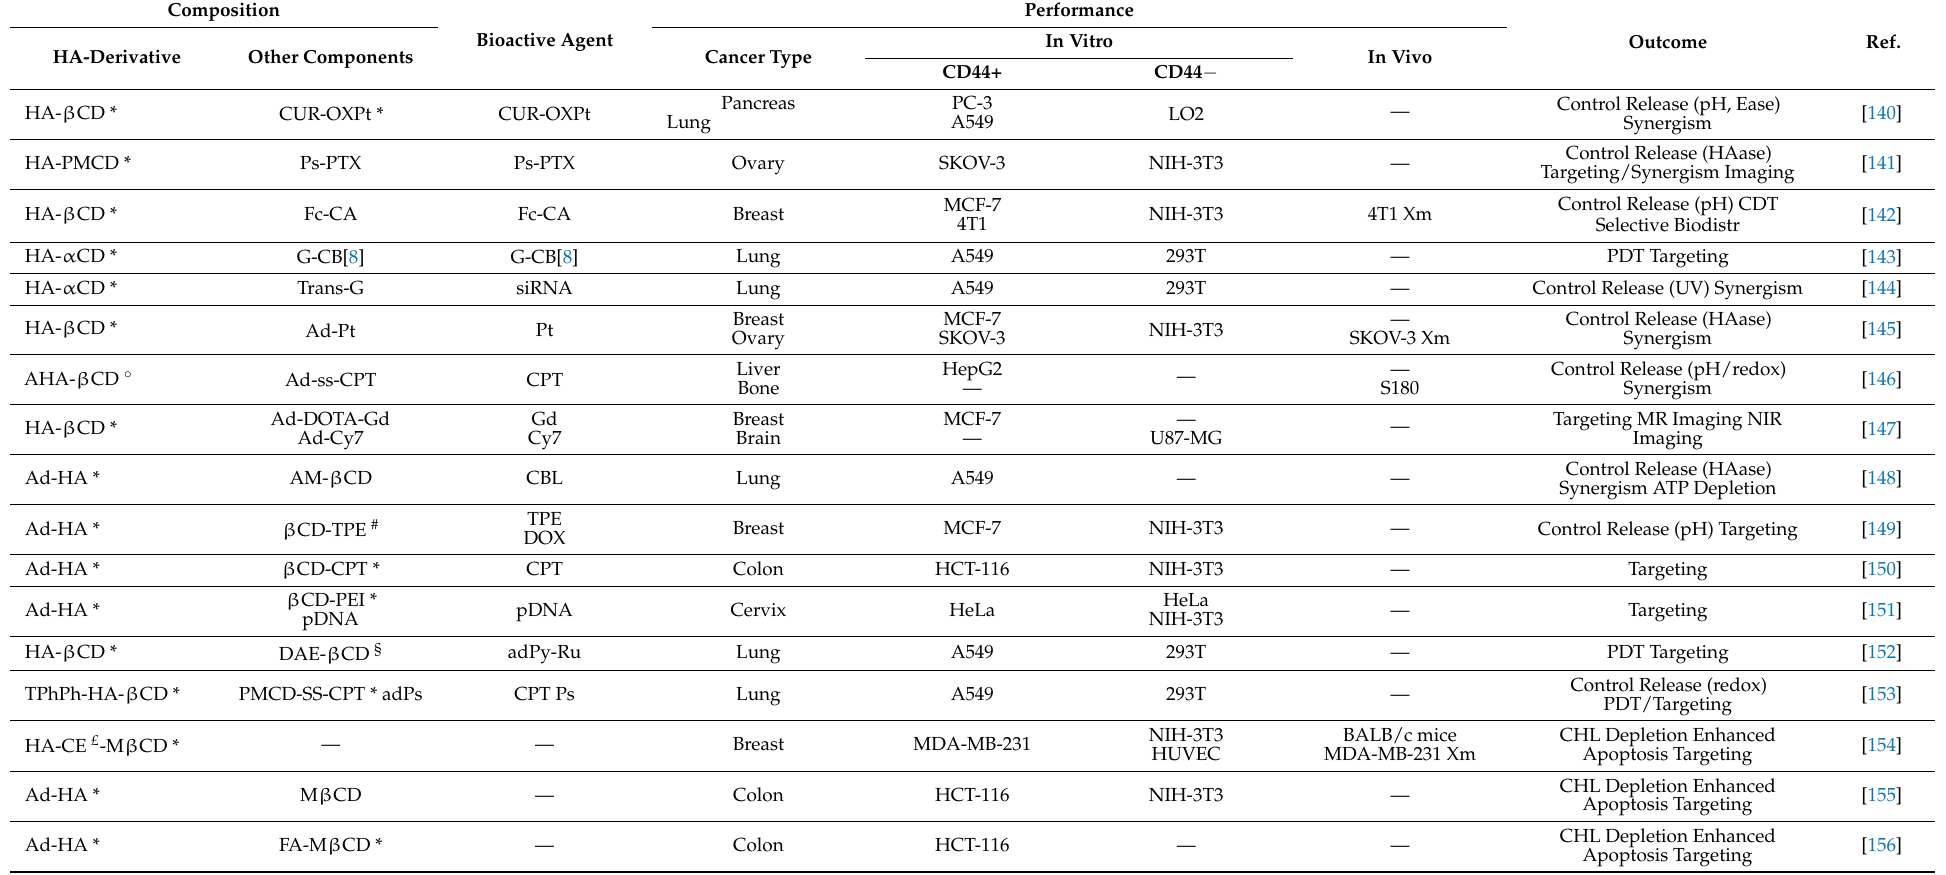
Table 6. HA-SANPs obtained by supramolecular